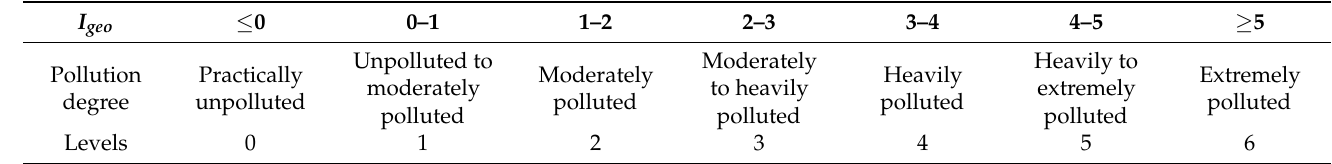
Table 1. Pollution classification of geo-accumulation